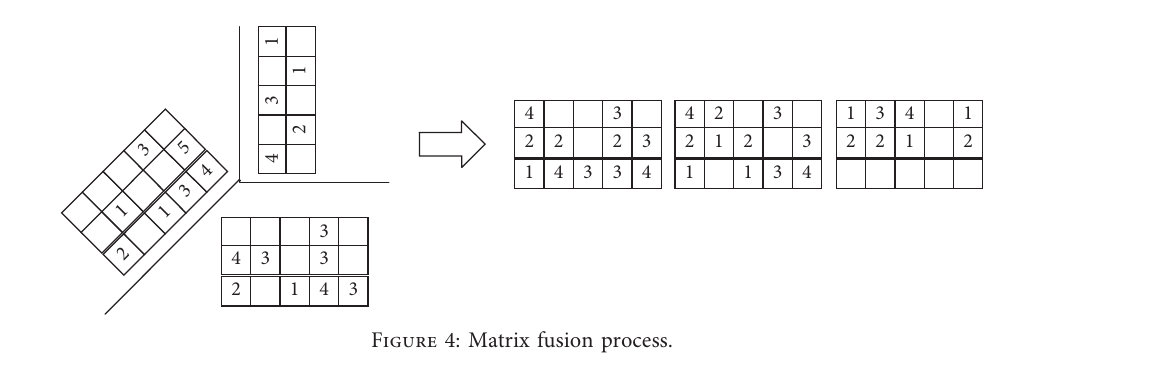
Figure 4: Matrix fusion